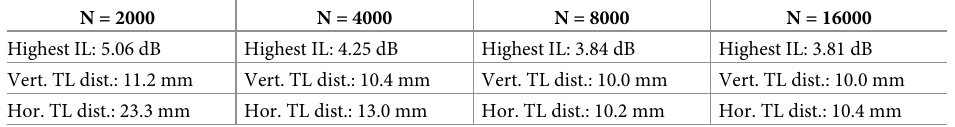
Table 3. Performance as a function of the number of algorithm executions for the full-sized matrix